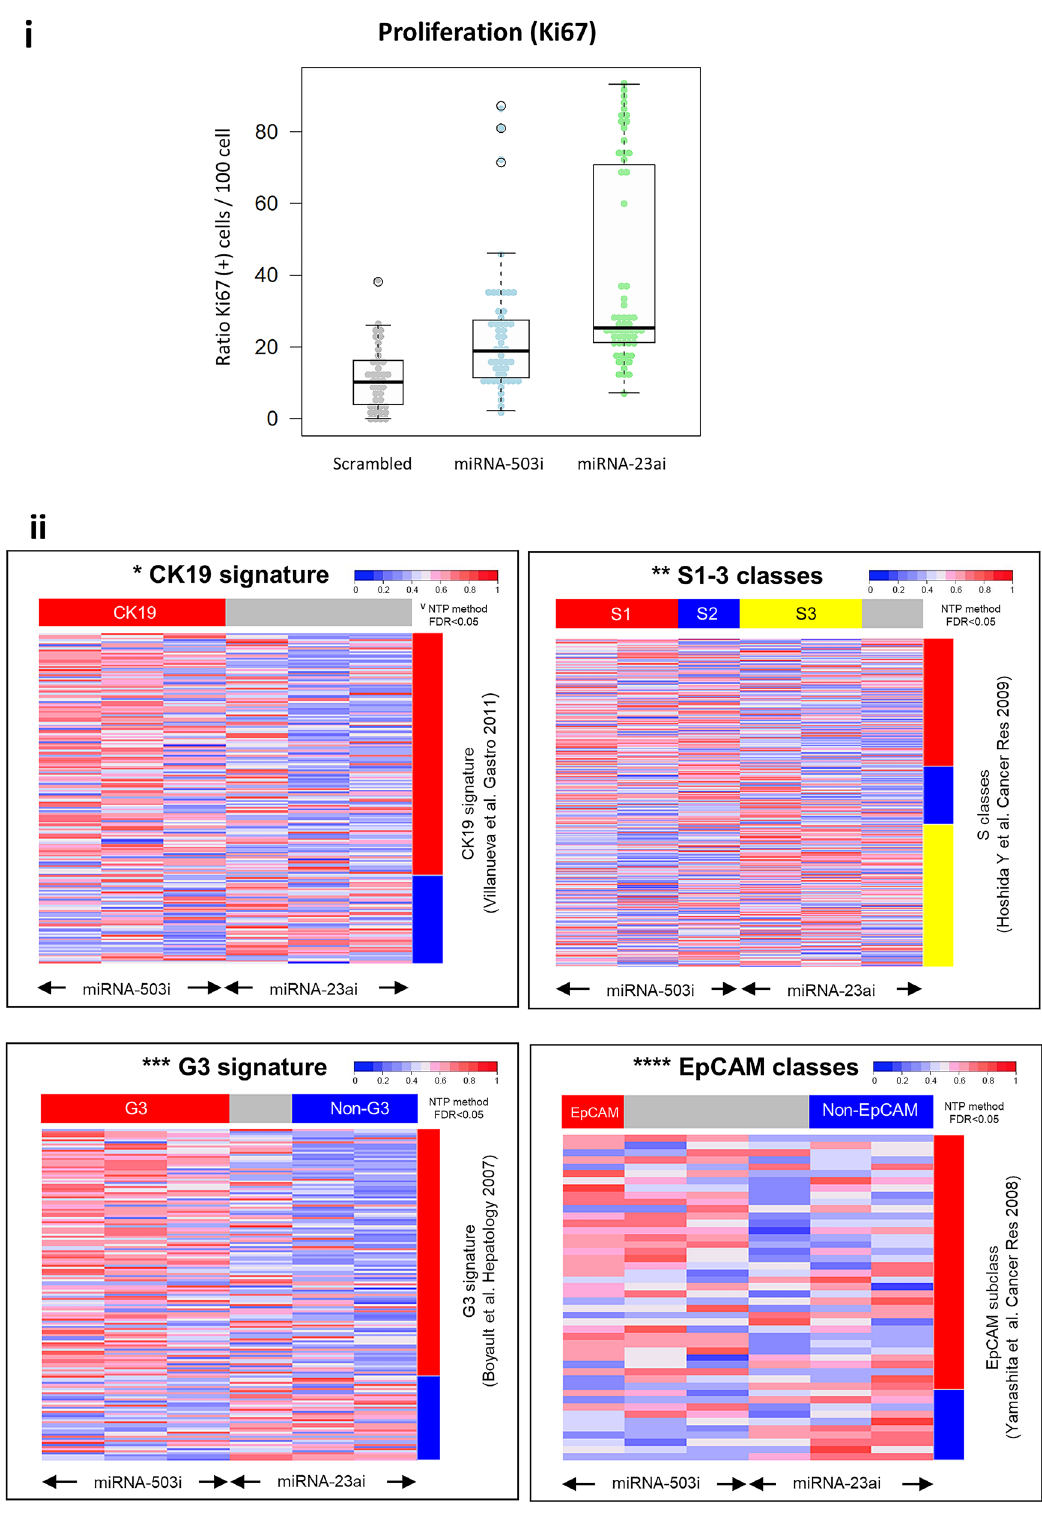
Figure 4. Ki67 proliferation index in xenograft tumors generated with miRNA constructs and comparison of cancer signature between these tumors and HCC cancer panels (i): Ki-67 expression ratio: Ki-67 positive cells per 100 cells obtained from tumor tissues transduced with scrambled control vector, miRNA-503i and miRNA-23ai. (ii): Comparing cancer signature between tumors developed in mice transduced with either miRNA-503i or miRNA-23ai using NTP method with FDR < 0.05 looking at known indicators of HCC. *CK-19: (cytokeratin-19). **S1–S3: (three robust HCC subclasses (termed S1, S2, and S3), each correlated with clinical parameters such as tumor size, extent of cellular differentiation, and serum alpha-fetoprotein levels. An analysis of the components of the signatures indicated that S1 reflected aberrant activation of the WNT signaling pathway, S2 was characterized by proliferation as well as MYC and AKT activation, and S3 was associated with hepatocyte differentiation. ***EpCAM: (epithelial cellular adhesion molecule). ****G3: (Glypican 3). VNTP method: Nearest-Template Prediction method (NTP, extensively reviewed, Hoshida Y.